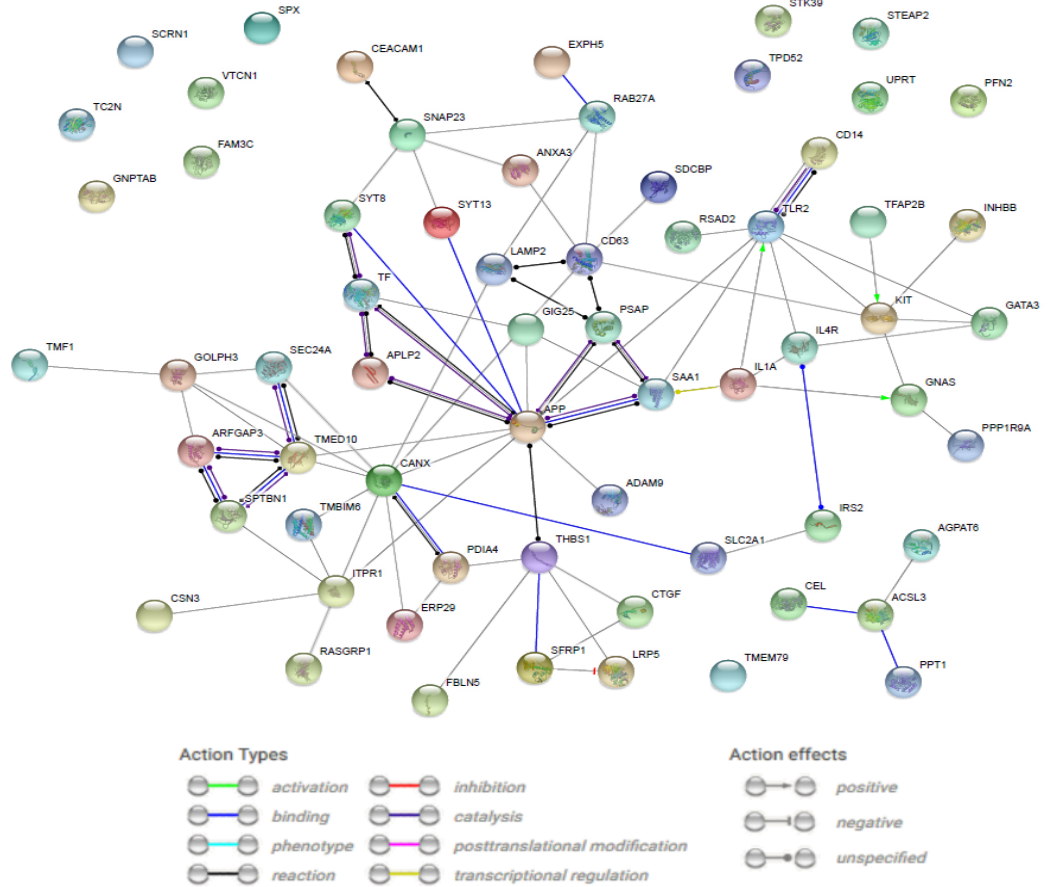
Figure 2. STRING-generated interaction network among differentially expressed genes belonging to the “secretion” ontology group. The intensity of the edges reflects the strength of the interaction score. Prediction methods applied: text mining, co-expression, and experimentally observed interactions.